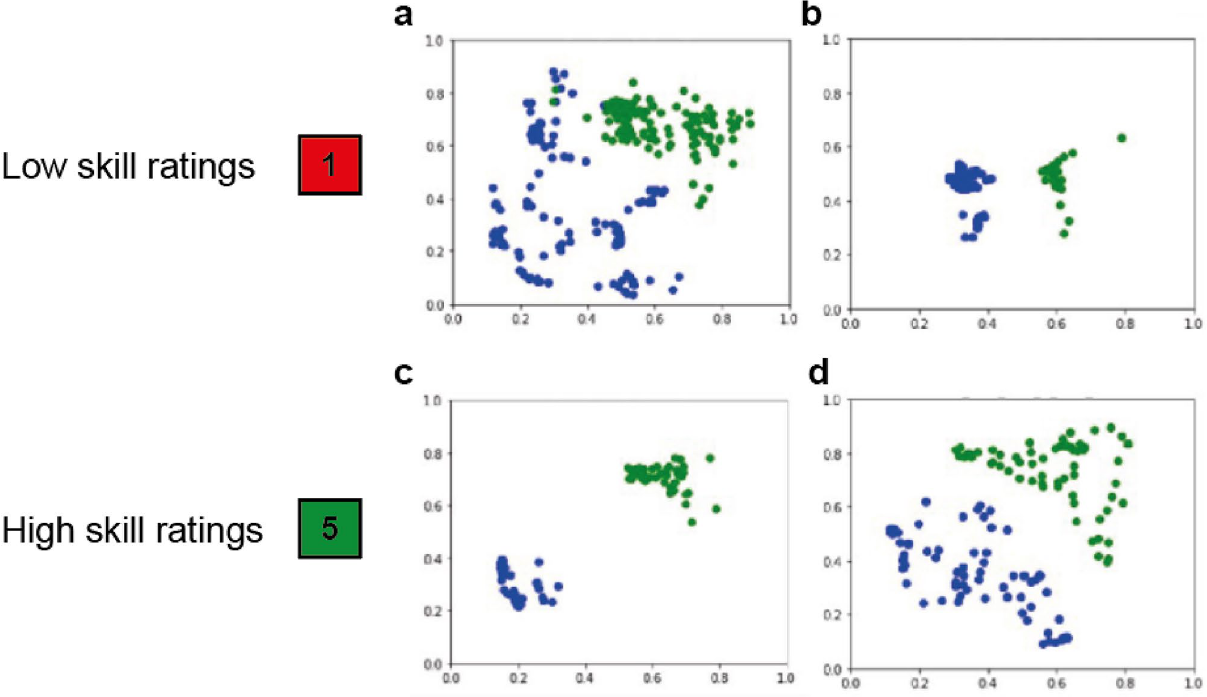
Figure 4. Examples on how camera movement and zoom affect instrument localizations (blue: grasper, green: clipper). ( a ) Low surgical skill rating and dispersed movement pattern. ( b ) Low surgical skill rating and precise movement pattern (clip lost). ( c ) High skill rating and precise movement pattern (camera zoomed out). ( d ) High skill rating and dispersed movement pattern (camera zoomed